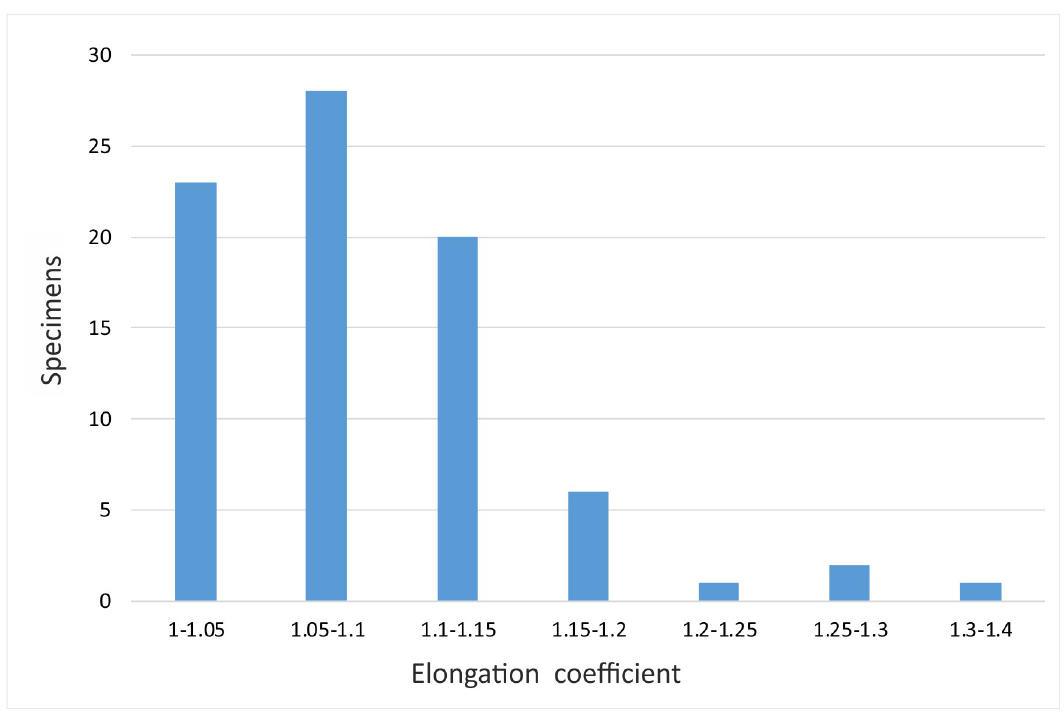
Fig 9. Diagram representing the elongation coefficient (Ec = L/W) of Cadosinopsis rehakovii sp. nov.